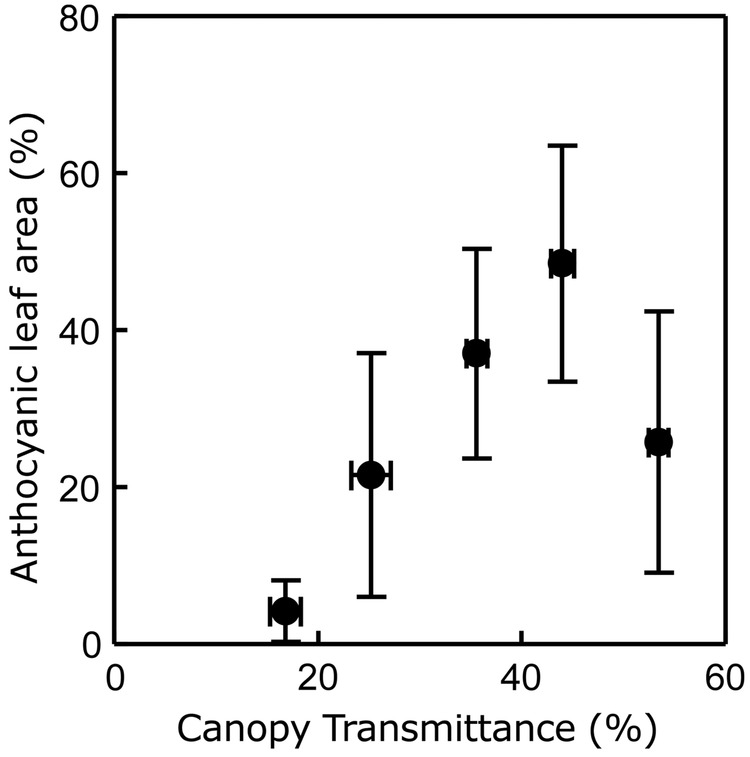
Influence of canopy openness on the winter reddening process of S. hirsuta leaves at the beginning of the winter. Each point represents the mean ± SE (n ≥ 4). The mean data of canopy openness and red area were grouped following steps of 10 % canopy openness over the whole canopy openness range, as follows: canopy openness ≤10, 11–20, 21–30, 31–40, 41–50, >51 %. All data were taken on a single day (19 November 2013).